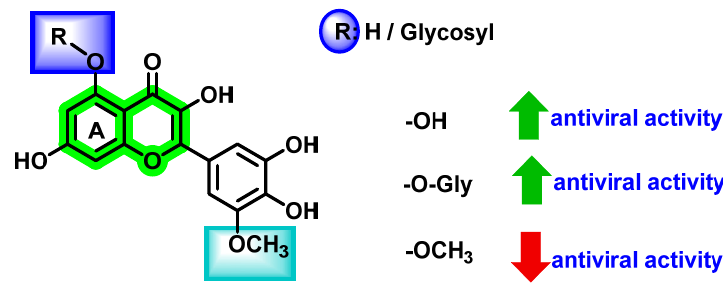
Figure 17. Effect of different substituent groups on flavonoid rings.